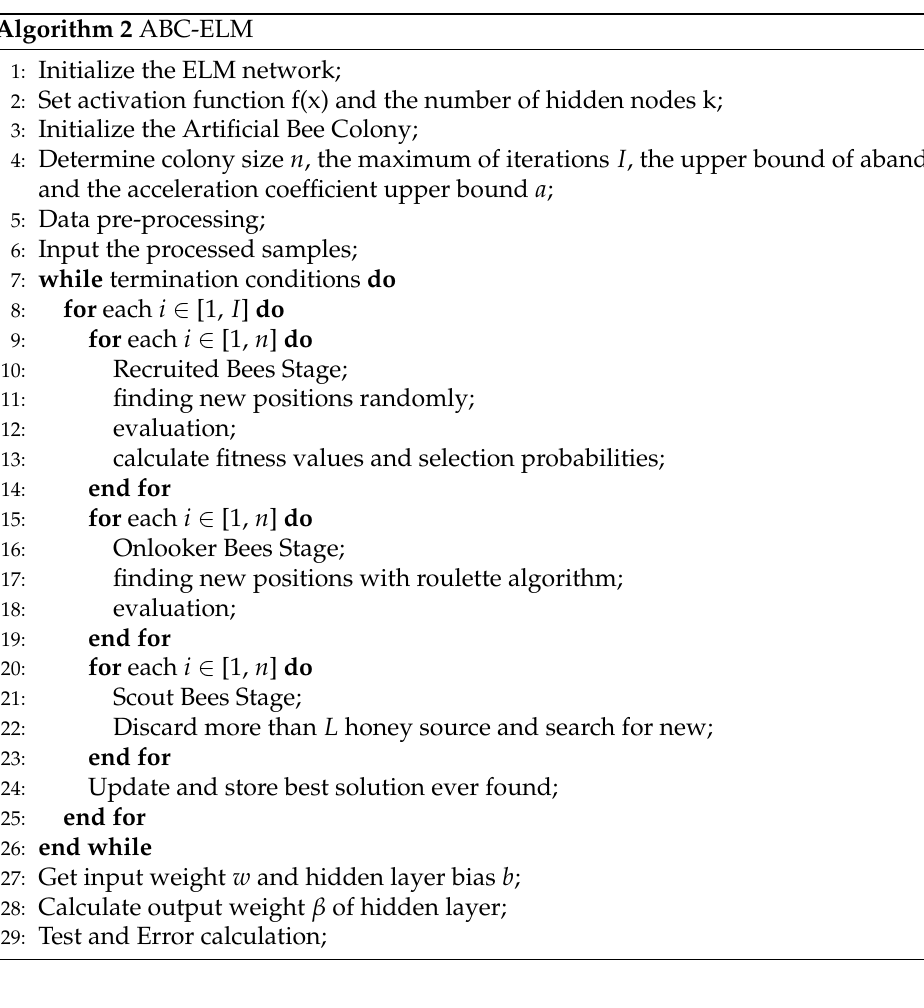
Figure 2. The workflow of ABC-ELM includes data pretreatment, ELM module, and ABC module. The ABC module passes the optimal solution back to the ELM module, where the predictions and calculations are